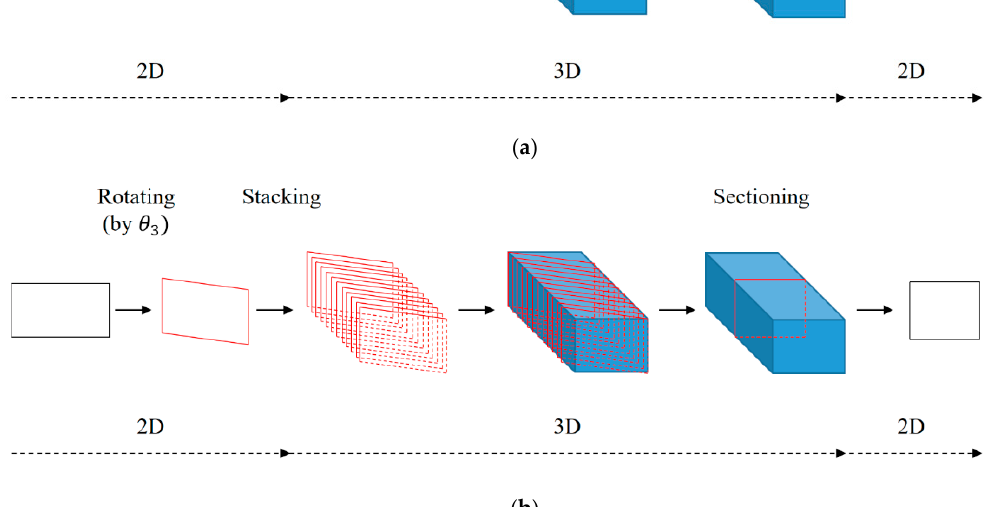
Figure 7. Calibration process for the ( a ) X w and ( b ) Z w rotation errors.